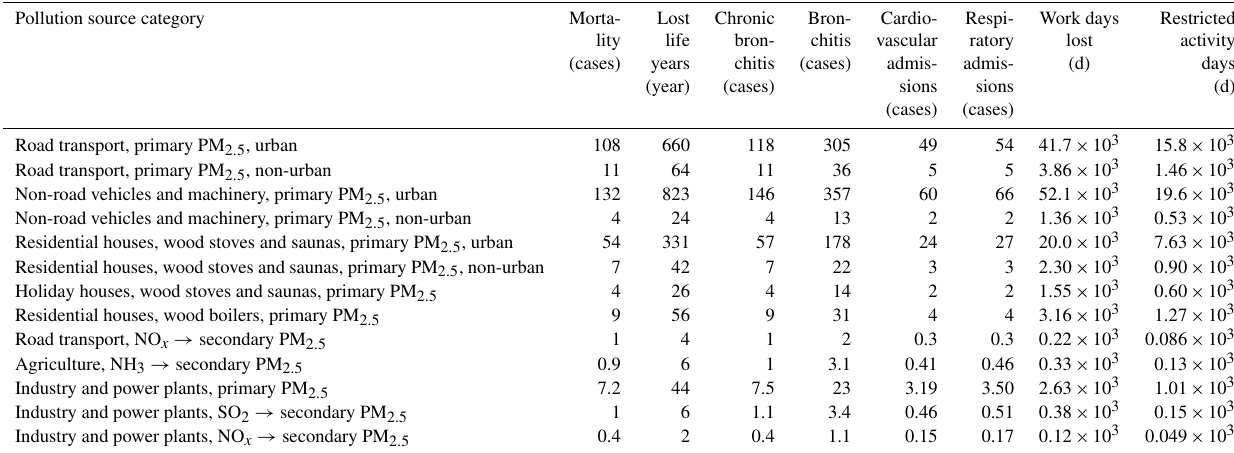
Table 3. The health impacts caused by an emission of 1kt of PM 2 . 5 , NO x , NH 3 or SO 2 in Finland in 2015 for various domestic pollution source categories in various regions. The notation, for example “NO x → secondary PM 2 . 5 ”, refers to secondary fine particulate matter that originated from the emissions of nitrogen oxides.